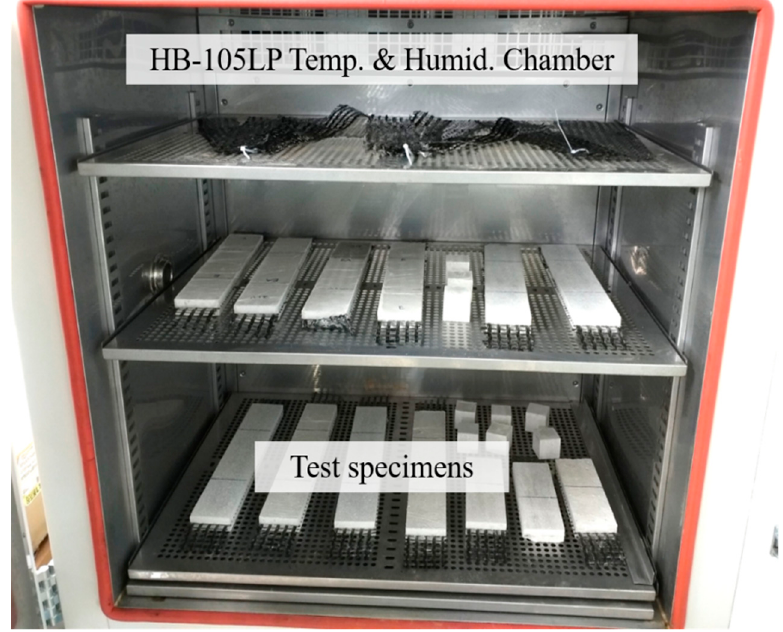
Figure 6. Photo of the test setup of TRM coupons subjected to the high temperature and humidity environment.